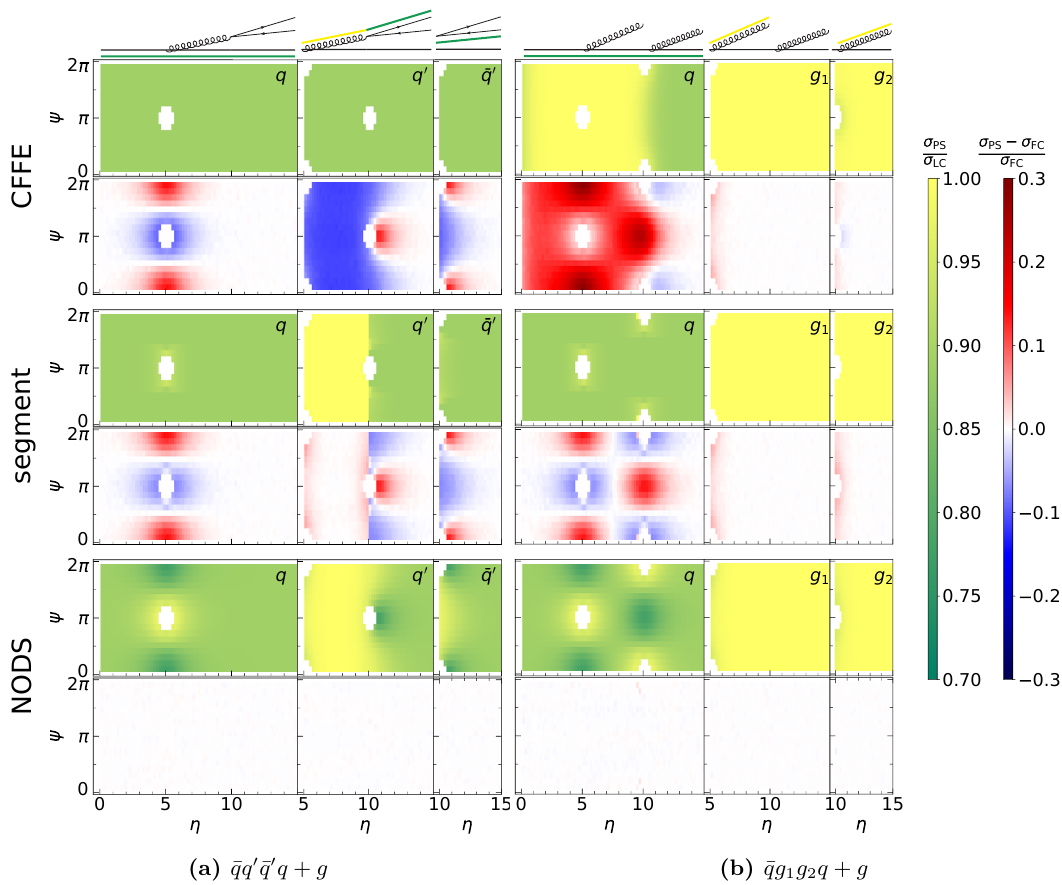
Figure 5. Colour factor assignment and relative deviation to the squared tree-level matrix element, as in figure 4, for the 2 → 4 + g configurations (a) ¯ qq 0 ¯ q 0 q + g and (b) ¯ qg respectively to the Lund diagrams in figures 2c and 1a (with g The results have been obtained with the β = 0 PanGlobal shower